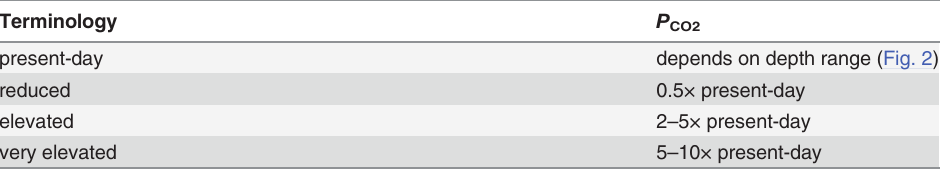
Table 1. Terminology used in the text to quantify levels of P CO2 used in manipulation experiments. S2 Table provides details for each treatment in each experiment